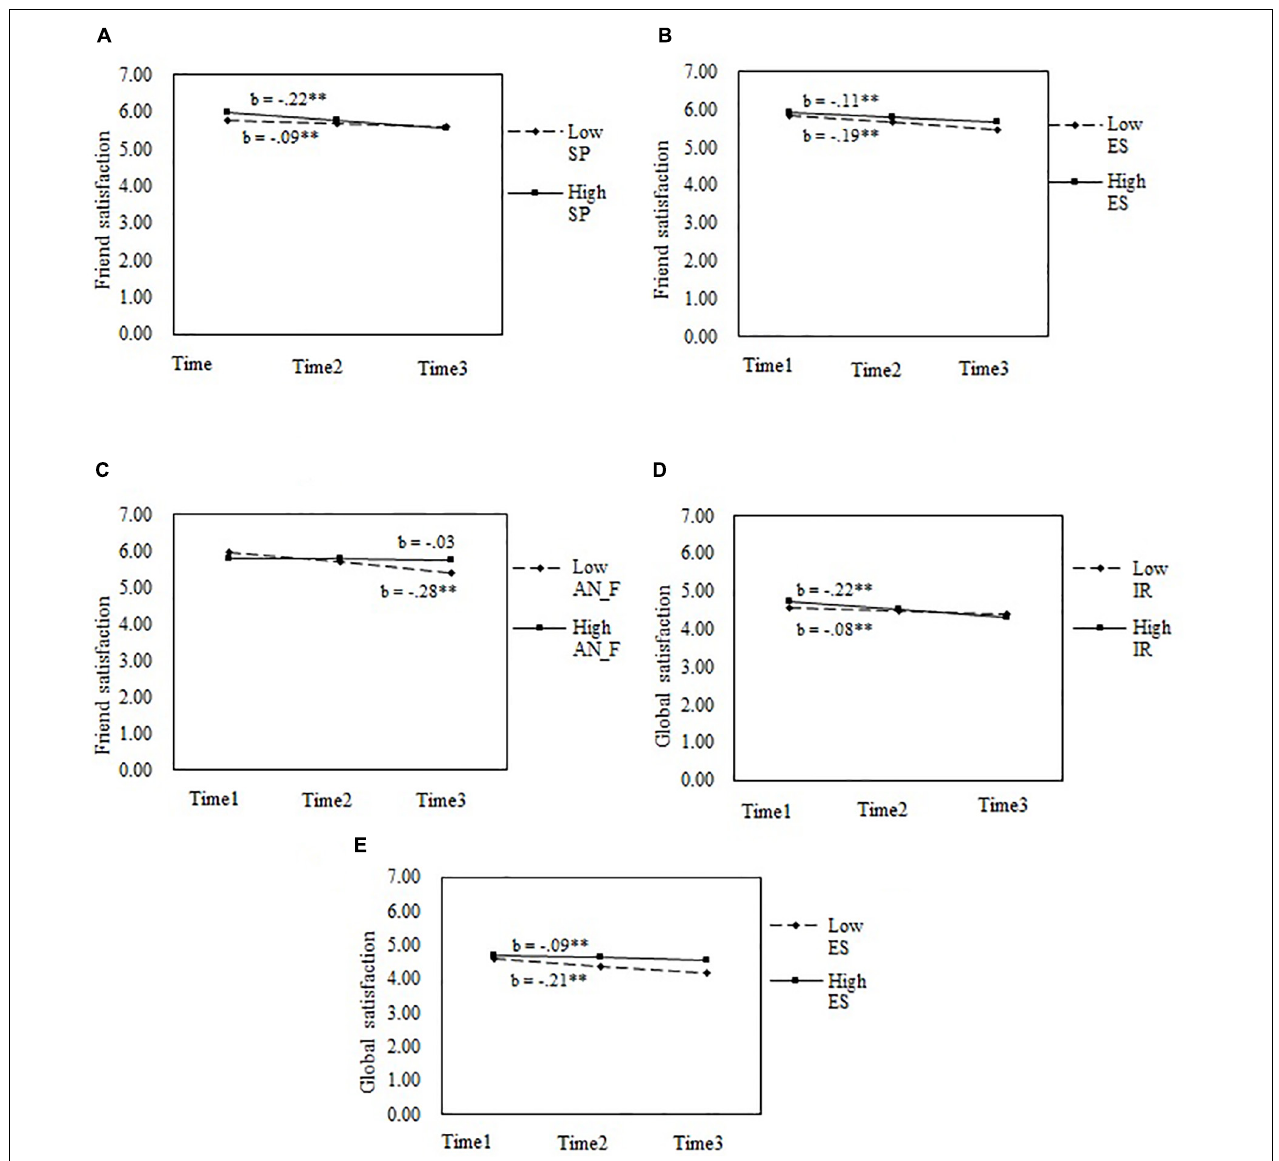
FIGURE 1 | Moderating effects of personality and parenting styles on the growth of life satisfaction from Grade 6 to Grade 8. SP, social potency; ES, emotional stability; IR, interpersonal relatedness; AN_F, paternal authoritarian style. (A–C) The moderating effects of social potency, emotional stability, and paternal authoritarian style on growth of friend satisfaction, respectively. (D,E) The moderating effects of interpersonal relatedness and emotional stability on growth of global satisfaction, respectively. ∗ p < 0.05; ∗∗ p <